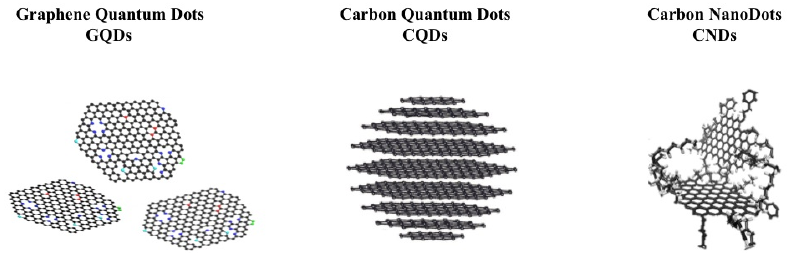
Figure 4. Illustration of the types of CDs considered. Carbon quantum dots (CQDs), graphene quantum dots (GQDs) and carbon nanodots (CNDs).